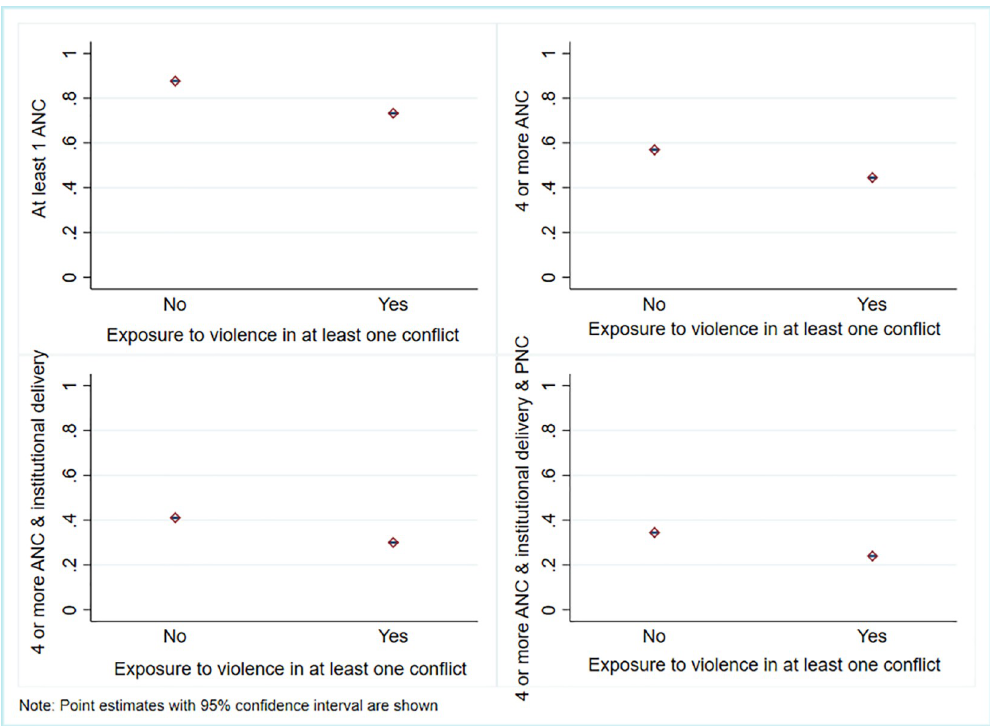
Fig 4. Levels of different components of CoC in maternal healthcare by the intensity of the